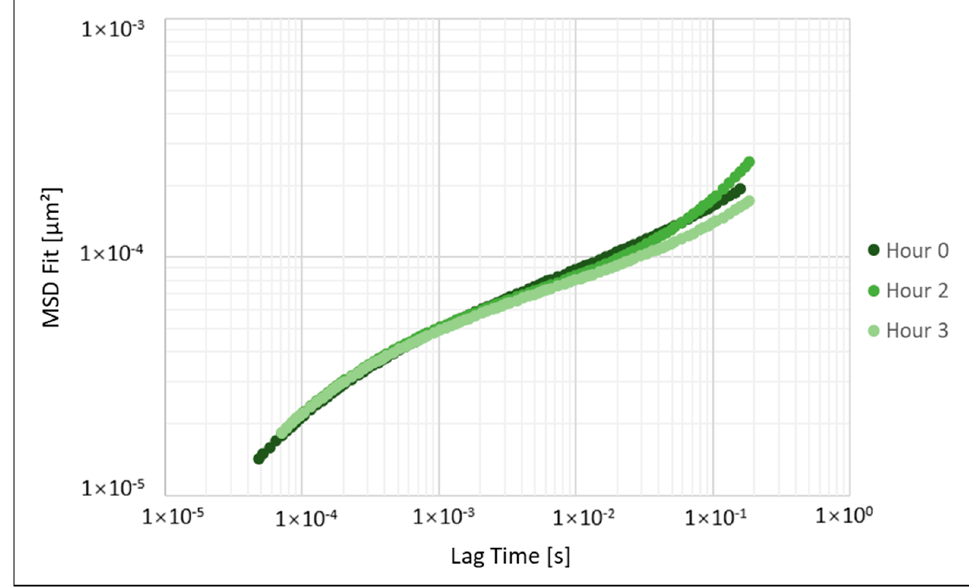
Figure 7. 3.5 wt % CAPB, 3.5 wt % SLES, 15 wt % avocado oil emulsion variation in MSD values over a 3 ‐ h period.